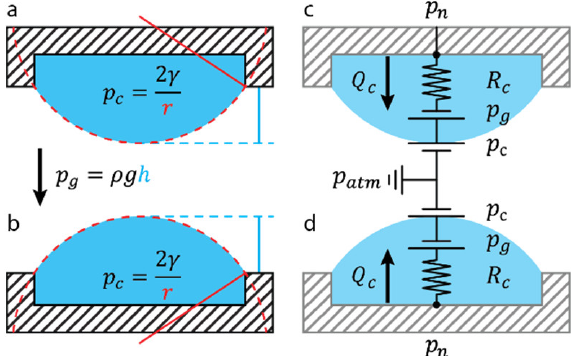
Figure 3. Circuit equivalence of drop compartments. Schematic representation of ( a ) a hanging- drop and ( b ) a standing-drop compartment and the capillary pressure p c applied by the curvature r of the air–liquid interface (ALI) from a reference atmospheric pressure p atm . Circuit equivalence of fluid movement in ( c ) a hanging and ( d ) a standing drop. At equilibrium, the equivalence p n = p c ± p g holds, and no flow is induced. An increase in p n due to hydrostatic pressure (e.g., by tilting the chip or elevating an inlet reservoir) or hydrodynamic pressure (e.g., fluid motion within the fluidic network) generates a net flow Q c = ∆ p / R c toward the drop ALI. An increase in drop volume due to the ALI reduces r . A reduction in r induces an increase in p c , which eventually reaches a new equilibrium with p n , stopping flow toward the ALI at a new drop volume.